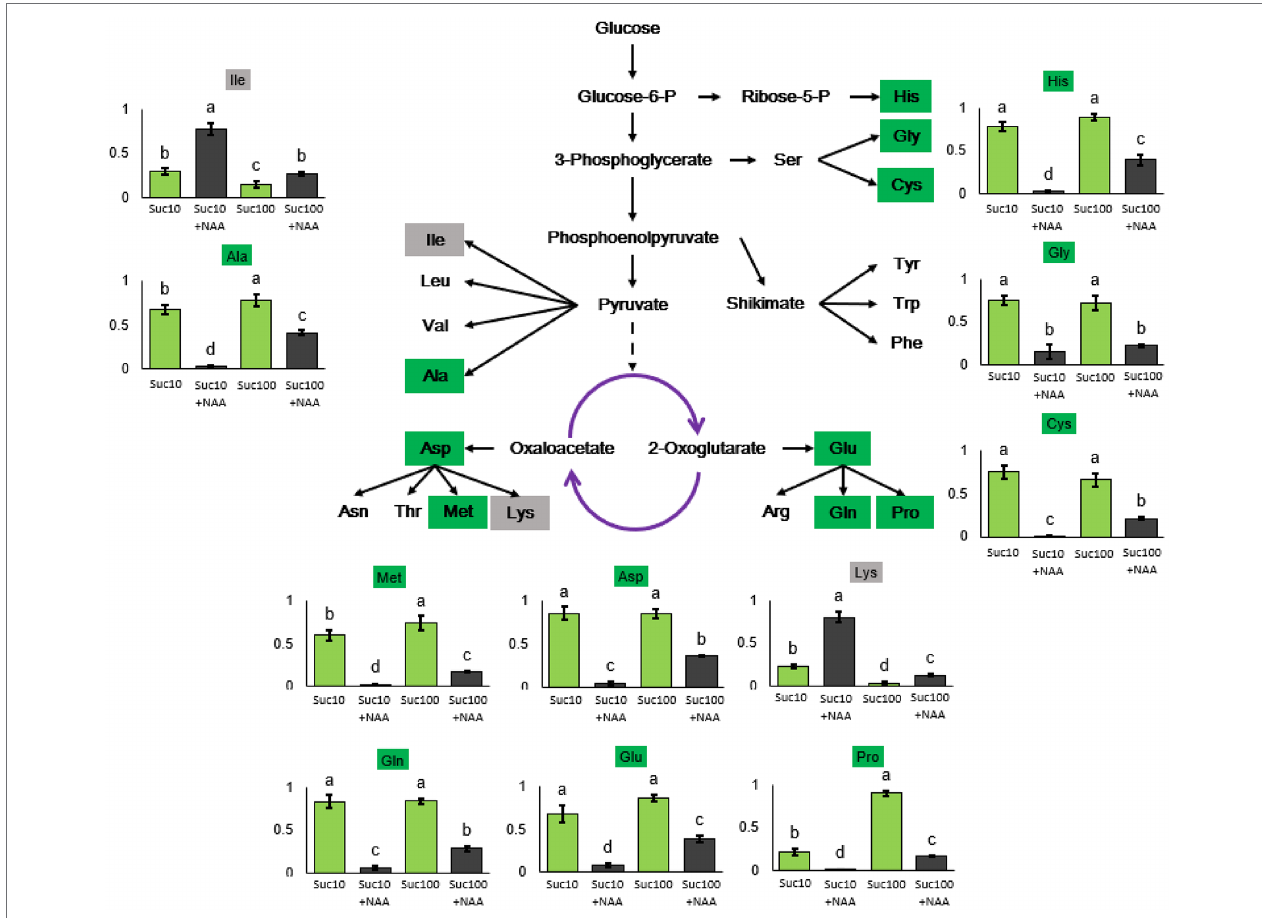
FIGURE 4 | Amino acid levels in axillary buds following different treatments. Suc10, 10 mM sucrose; Suc10 + NAA, 10 mM sucrose +1 μ M NAA; Suc100, 100 mM sucrose; and Suc100 + NAA, 100 mM sucrose +1 μ M NAA. Dark green label, amino acid inhibited by auxin but stimulated by sucrose [nine amino acids: Ala (alanine), Asp (aspartate), Met (methionine), Glu (glutamate), Gln (glutamine), Pro (proline), His (histidine), Gly (glycine), and Cys (cysteine)]. Gray label, amino acid inhibited by sucrose, but stimulated by auxin [Ile (isoleucine) and Lys (lysine)]. Green and dark columns, sucrose- and sucrose+auxin-treated buds, respectively. Data are means ± standard errors (SEs). Letters, significant differences between the different treatments with p <